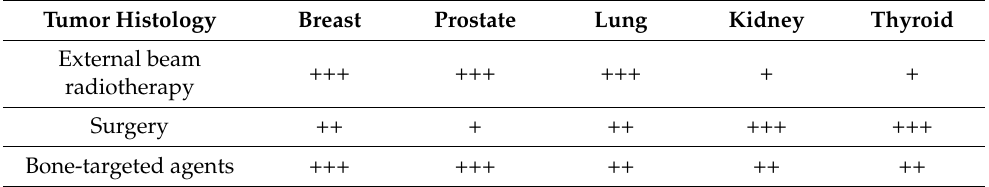
Table 2. Expected therapeutic response to radiotherapy, surgery and bone-targeted agents, according to histologic subtype.